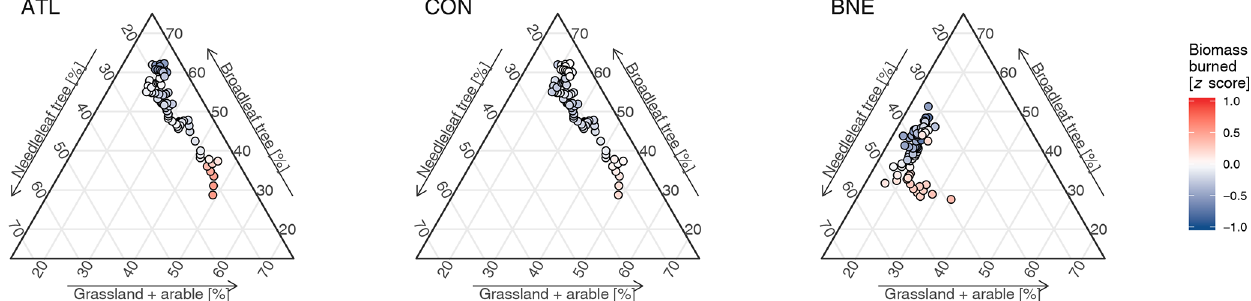
Figure 3. Relationship between biomass burning, broadleaf tree cover, needleleaf tree cover, arable cover and grassland cover over the past 8kyr in the three ecoregions in central and eastern Europe. Biomass burning and land cover are determined as above. Locations with greater biomass burning tend to be consistently characterized by low broadleaf tree cover in the CON and ATL ecoregions and by high needleleaf forest cover in the BNE ecoregion. In terms of land use, biomass burning increases with arable and pasture cover, but the patterns and thresholds vary between ecoregions, reflecting complex fire–human interactions. The coloured circles represent individual sampling points ( n = 80).